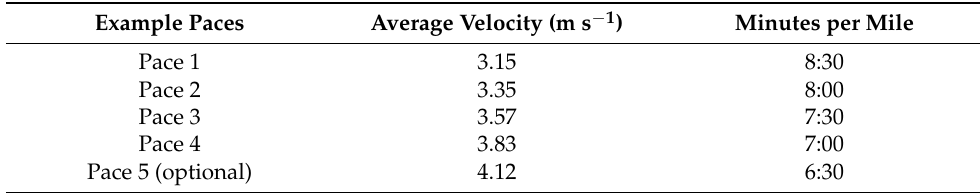
Table 2. Exemplar paces for participant with a 7 min per mile, 5 km race pace, and expected average velocity-corresponding pace in minutes per